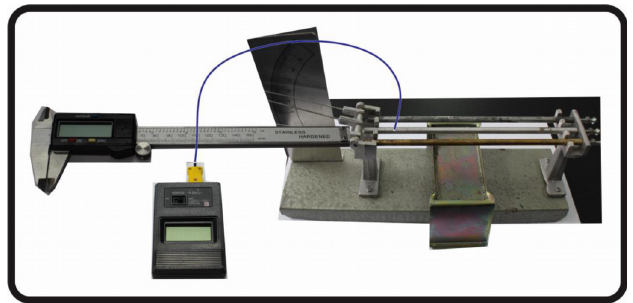
Figure 10. Fifth experiment design to construct the concept